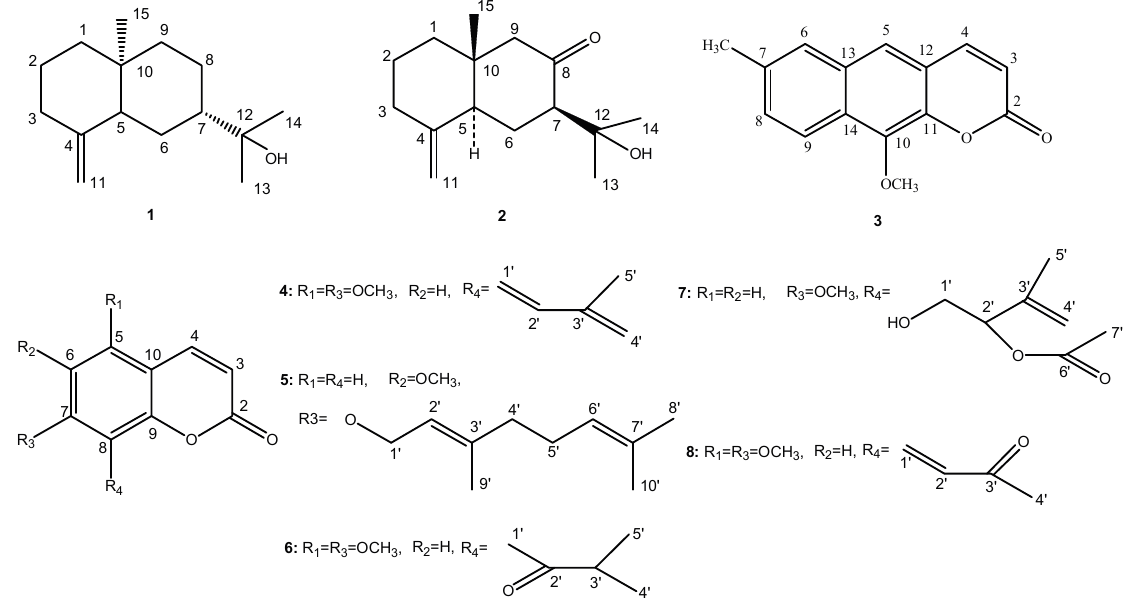
Figure 1. The structures of compounds 1 – 8